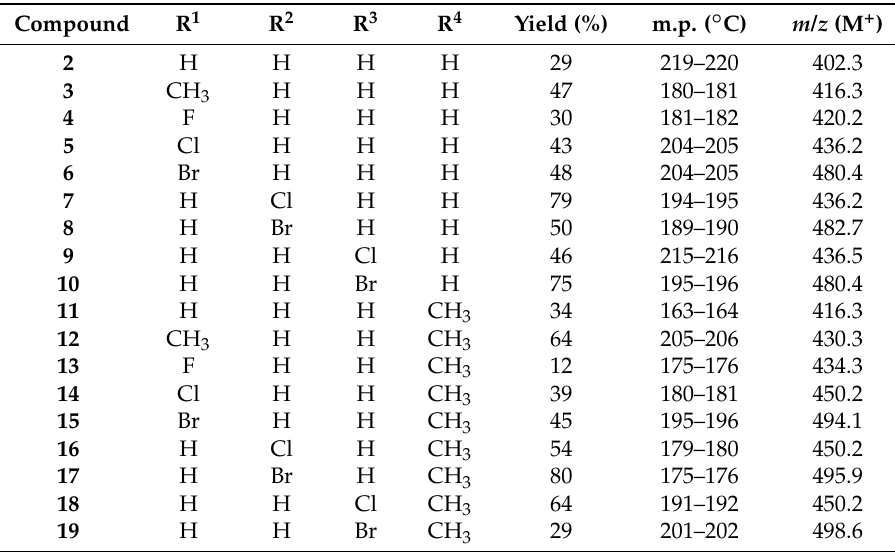
Table 1. Data for benzo[4,5]isothiazolo[2,3- a ]pyrazine-6,6-dioxide derivatives 2 – 19